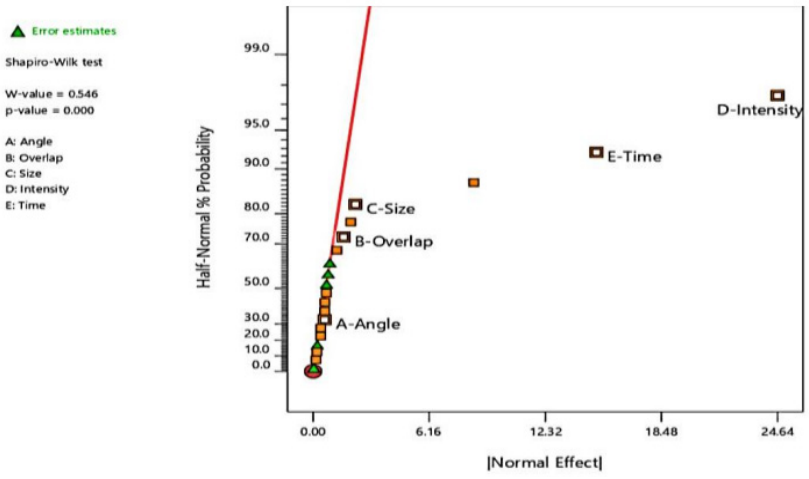
Figure 12. Half-normal percentage probability analysis plot for residual stress response.